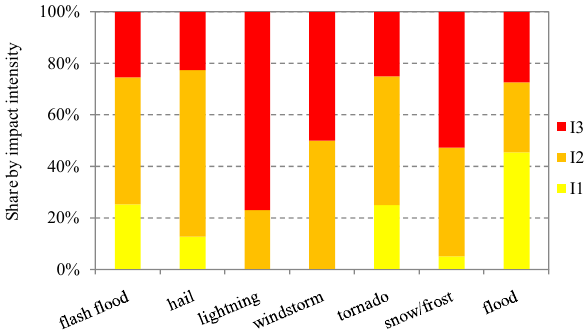
Fig. 8. Average impact range for each type of weather-related phe- nomenon.